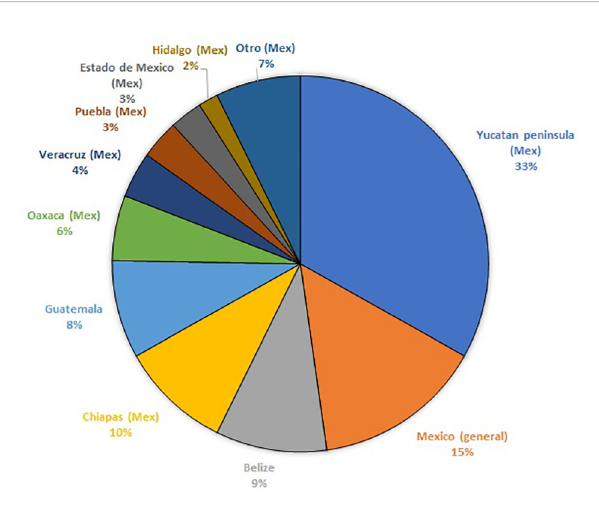
FIGURE 3 Distribution of scienti fi c articles by location (country or state in Mexico, with states in Mexico indicated by